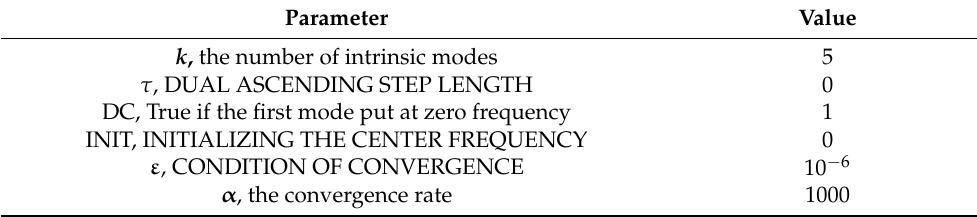
Table 2. Parameter of VMD algorithm.